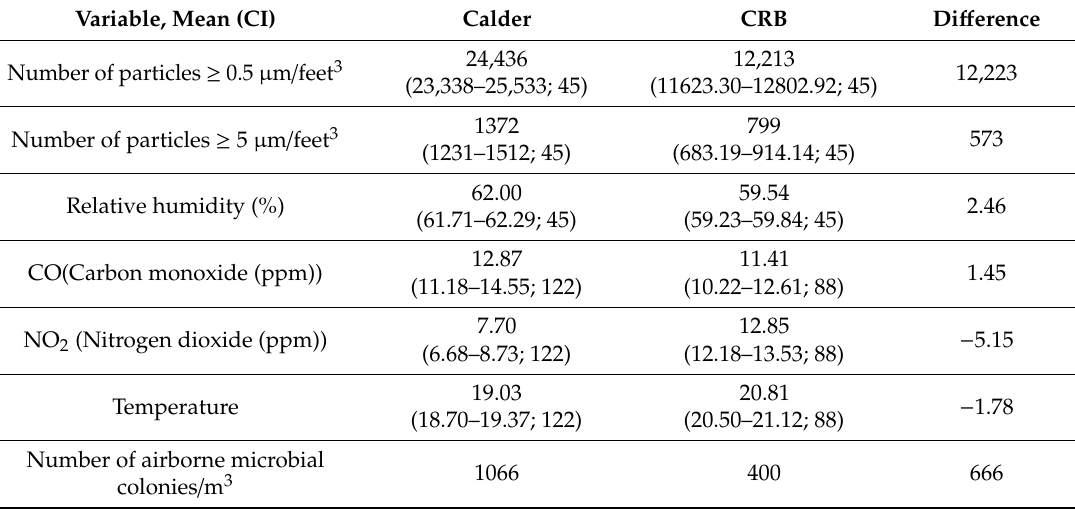
Table 2. Indoor environmental metrics inside Calder Library and